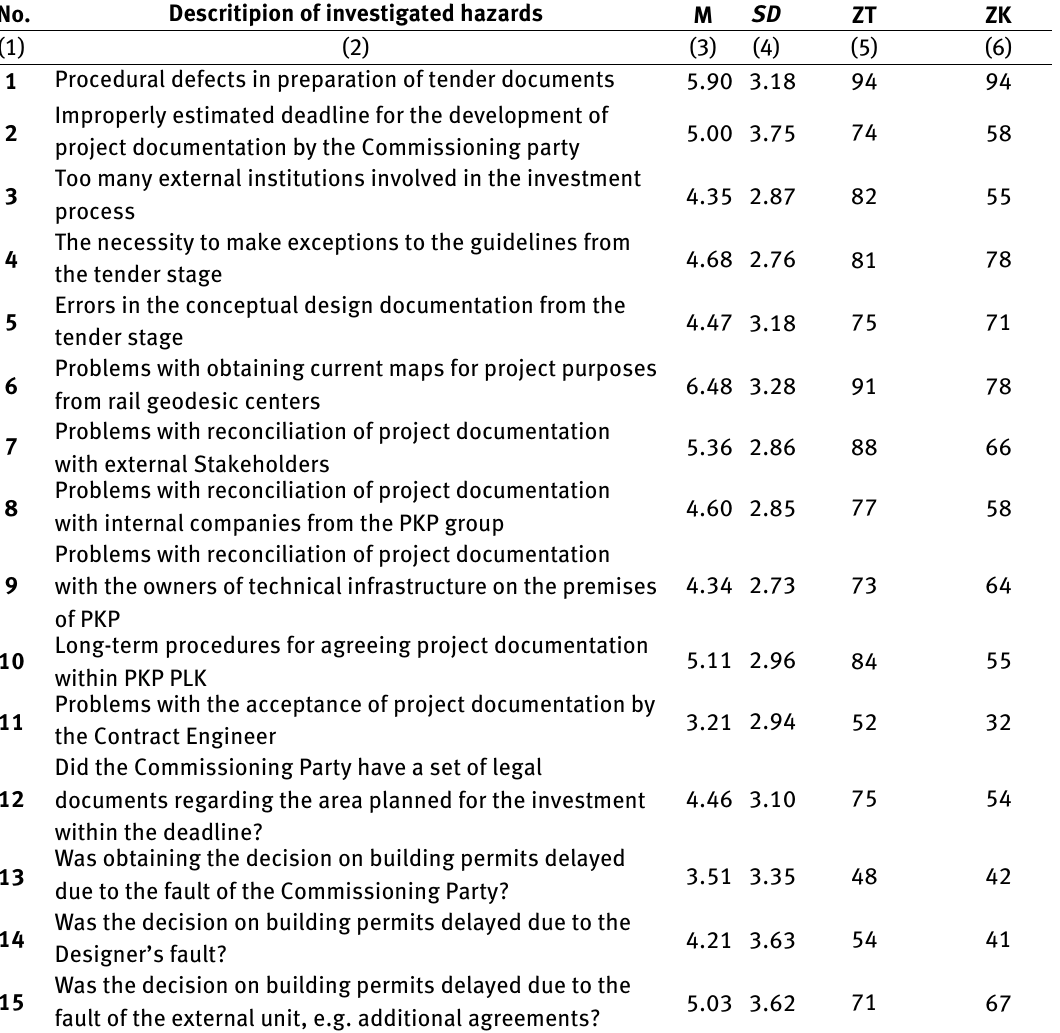
Table 1: Identified hazards - design